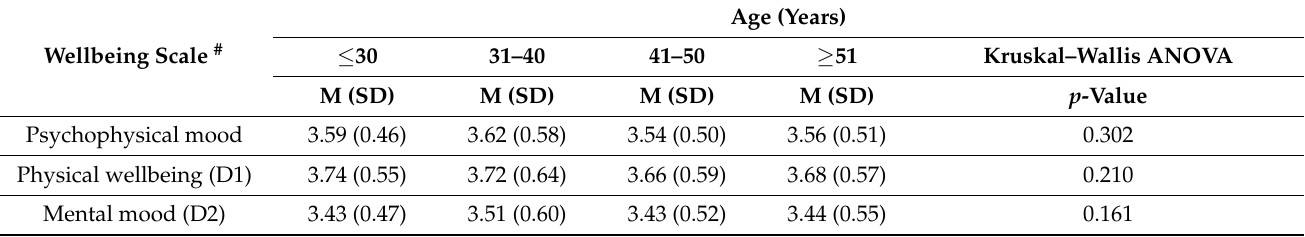
Wellbeing Scale